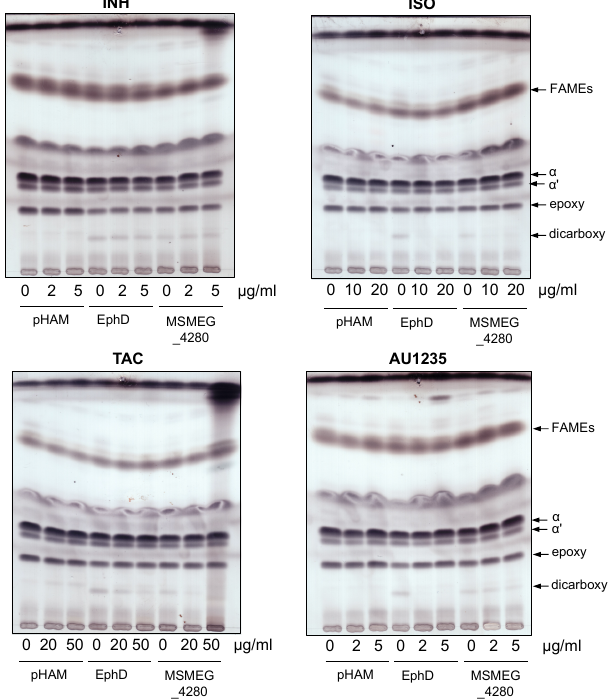
Figure 4. Thin-layer chromatography of fatty and mycolic acid methyl esters from strains M. smeg- matis mc 2 155 pHAM , pHAM- ephD and pHAM- msmeg_4280 treated with isoniazid (INH), ISO, thi- acetazone (TAC) or AU1235. Plates were developed in n -hexane:ethyl acetate (95:5, three runs) and visualized with 10% cupric sulfate in 8% phosphoric acid and charring. FAMEs—fatty acid methyl esters; α, α', epoxy and dicarboxy represent different forms of mycolic acid methyl esters (MAMEs).